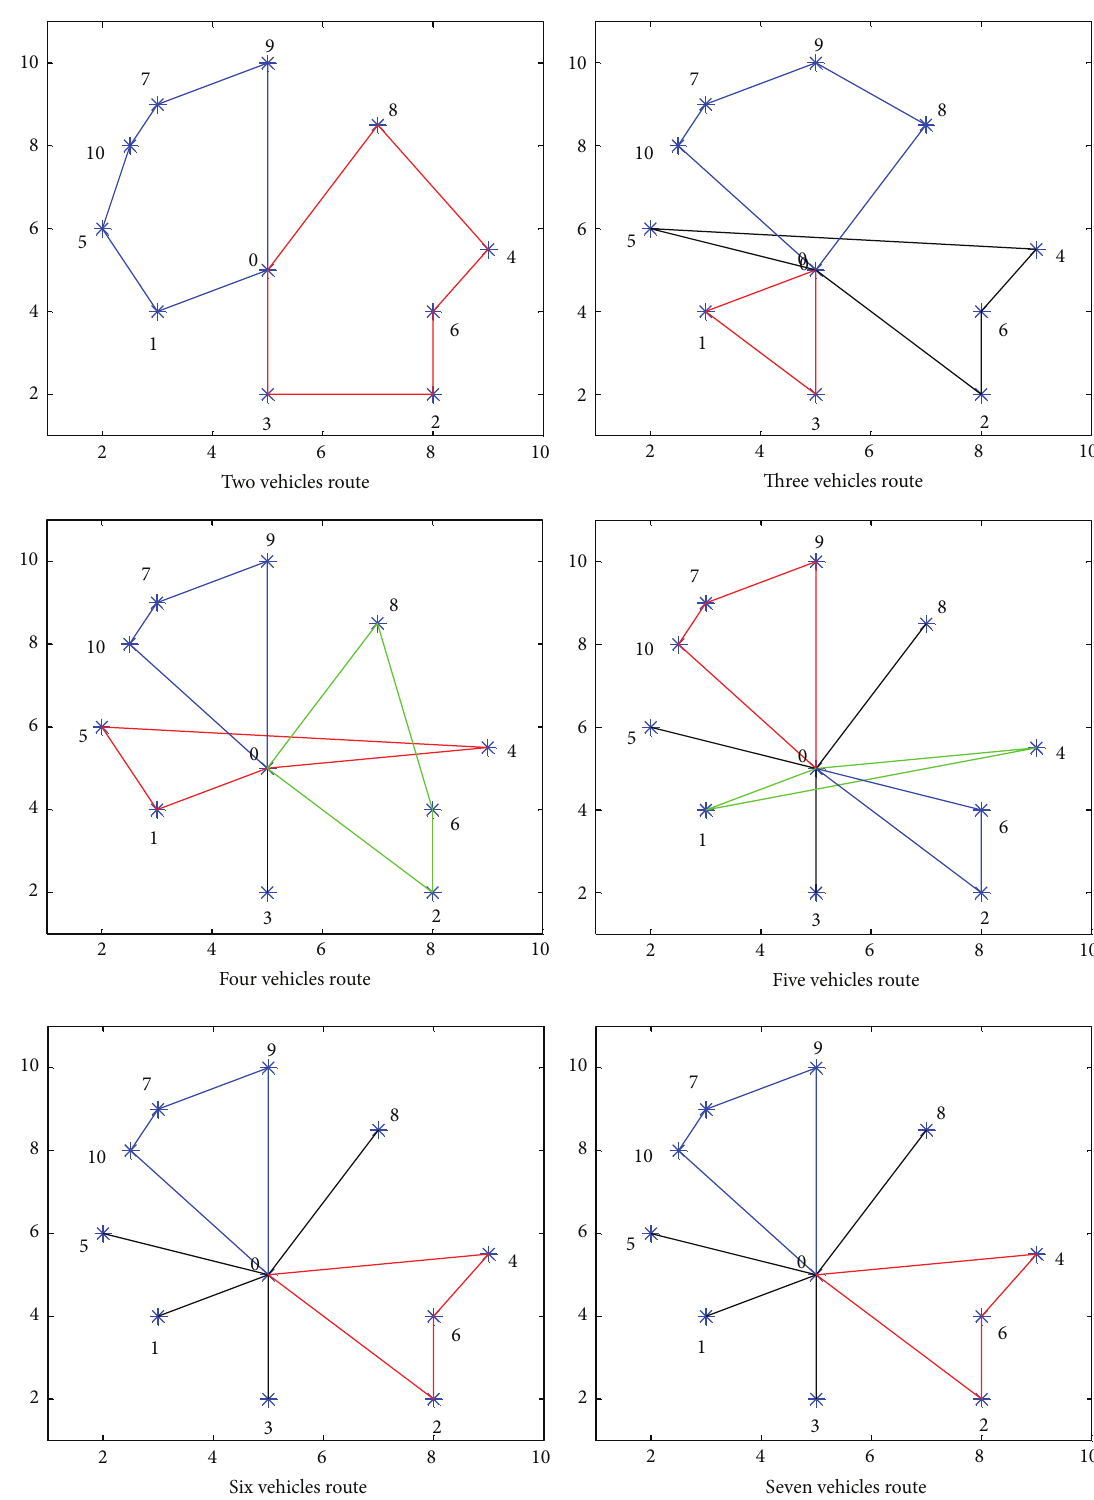
Figure 4: The vehicle routes with time-window constraints of different fleet